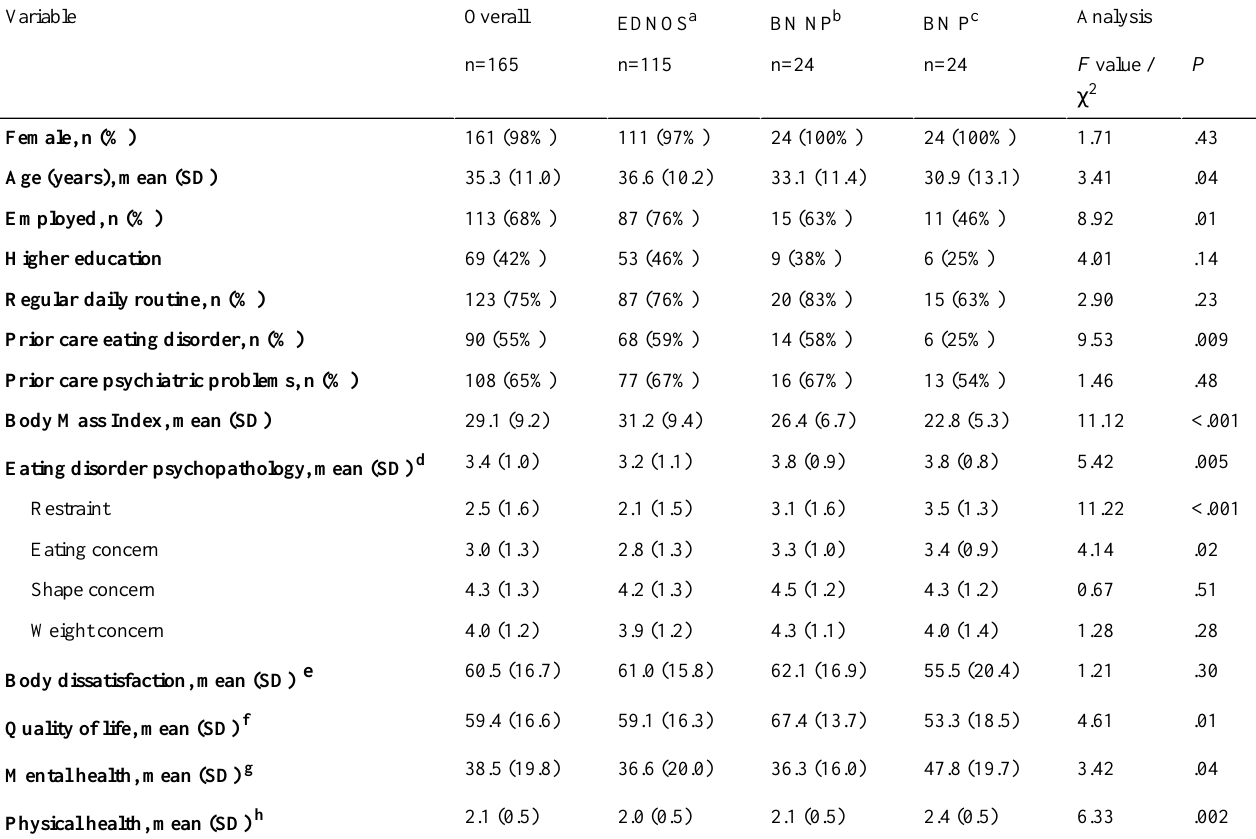
Table 1. Participant characteristics at baseline and differences between diagnostic